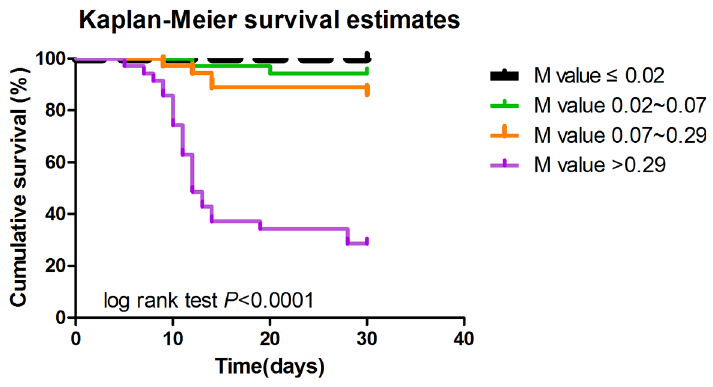
Fig 3. Survival curve of SFTS patients during 30 days’ follow-up based on risk score